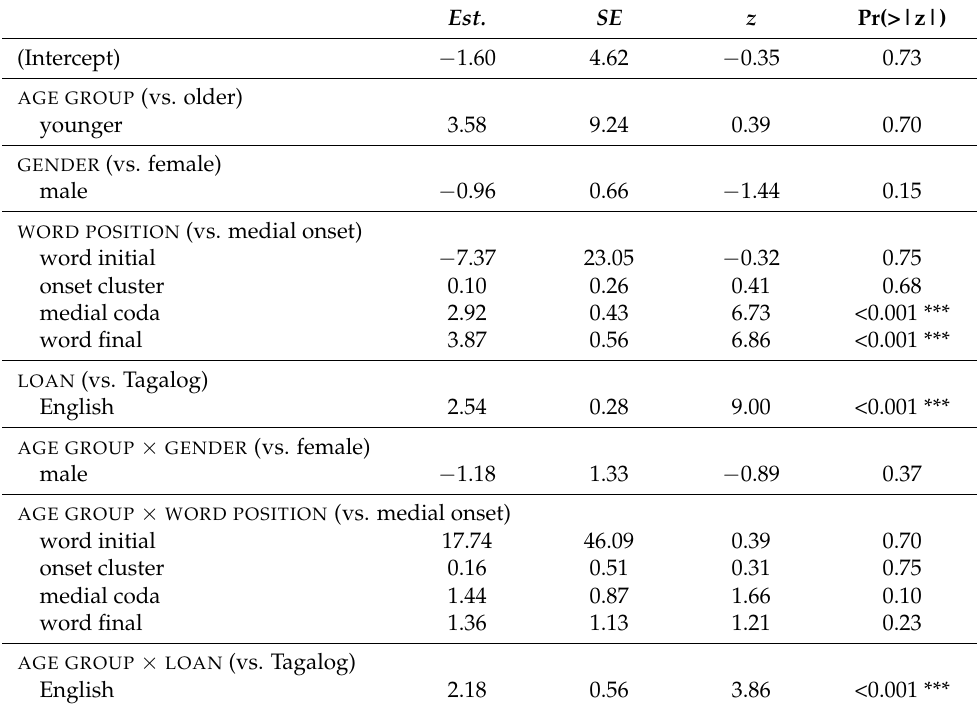
Table 7. Mixed-effects model for homeland speakers (n = 796). Positive estimate values indicate a favoring environment for the approximant. Significance code: <0.001 ‘***’.